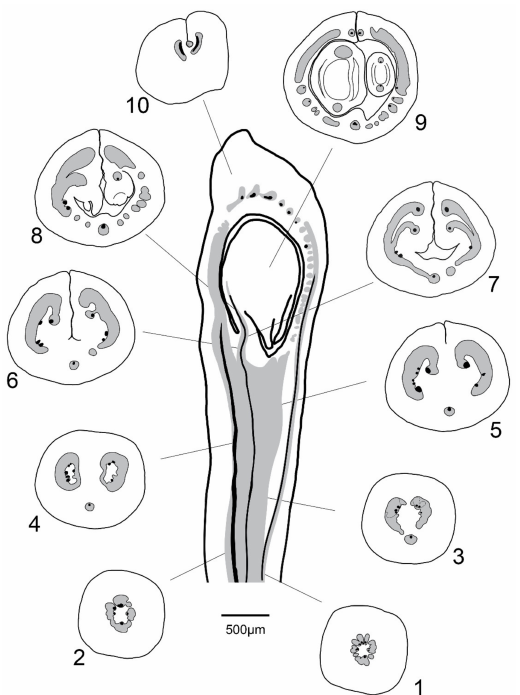
Figure A3. Carpel architecture of Anaxagorea javanica in fruit stage – longitudinal section with related ascending transverse